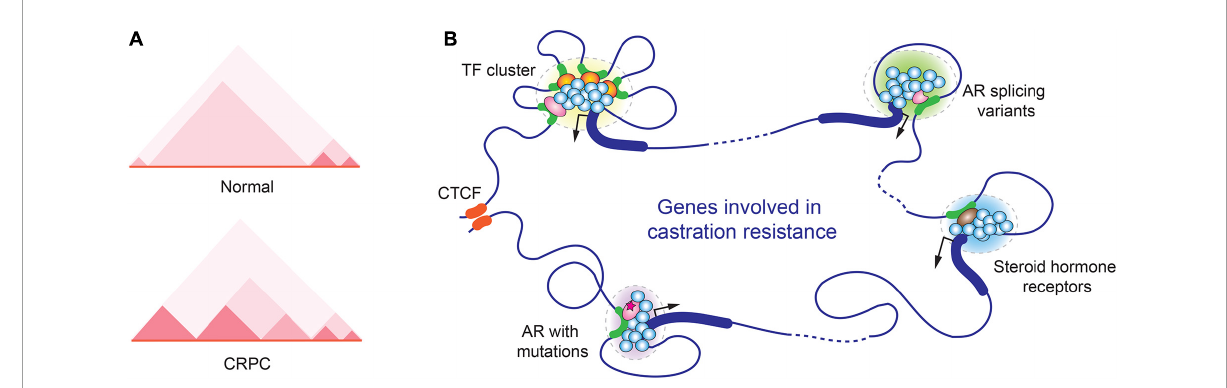
FIGURE2 Alterations in spatial organization of chromatin in CRPC. (A) Chromatin structure changes in the genomic region near the AR gene locus in normal prostate and CRPC cells. A representative TAD heatmap is illustrated. (B) A hypothetic schematic model for various transcription-associated condensates formed in